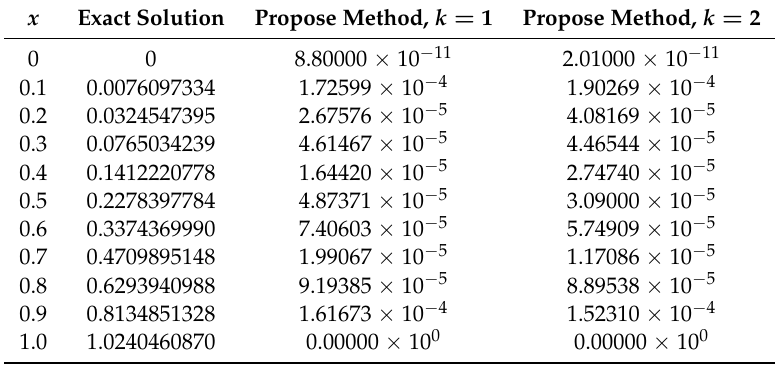
Table 1. Absolute errors for proposed method with k = 1,2 for Example